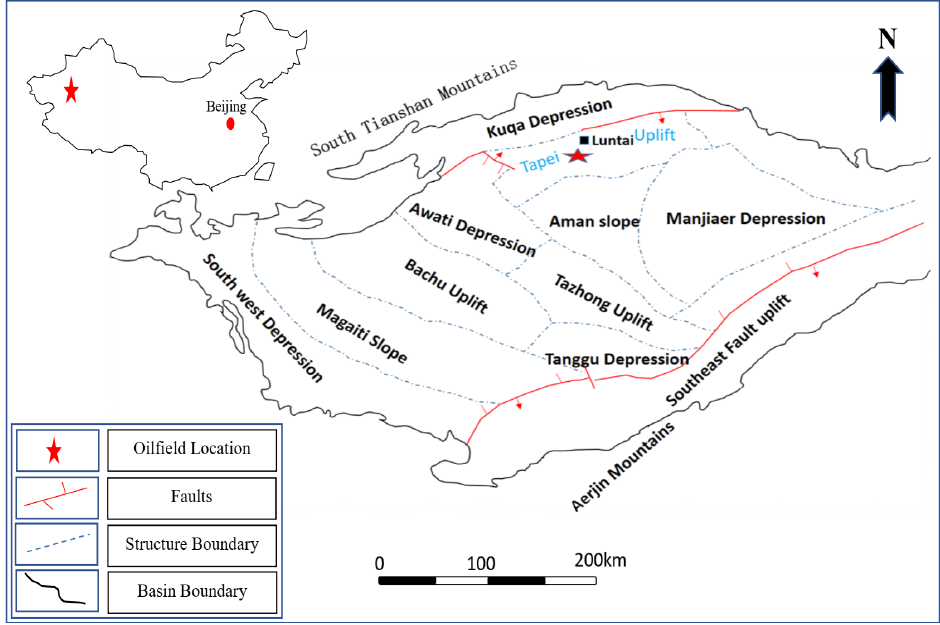
Figure 4. The second study area (The Tahe oilfield, Block 9, China).